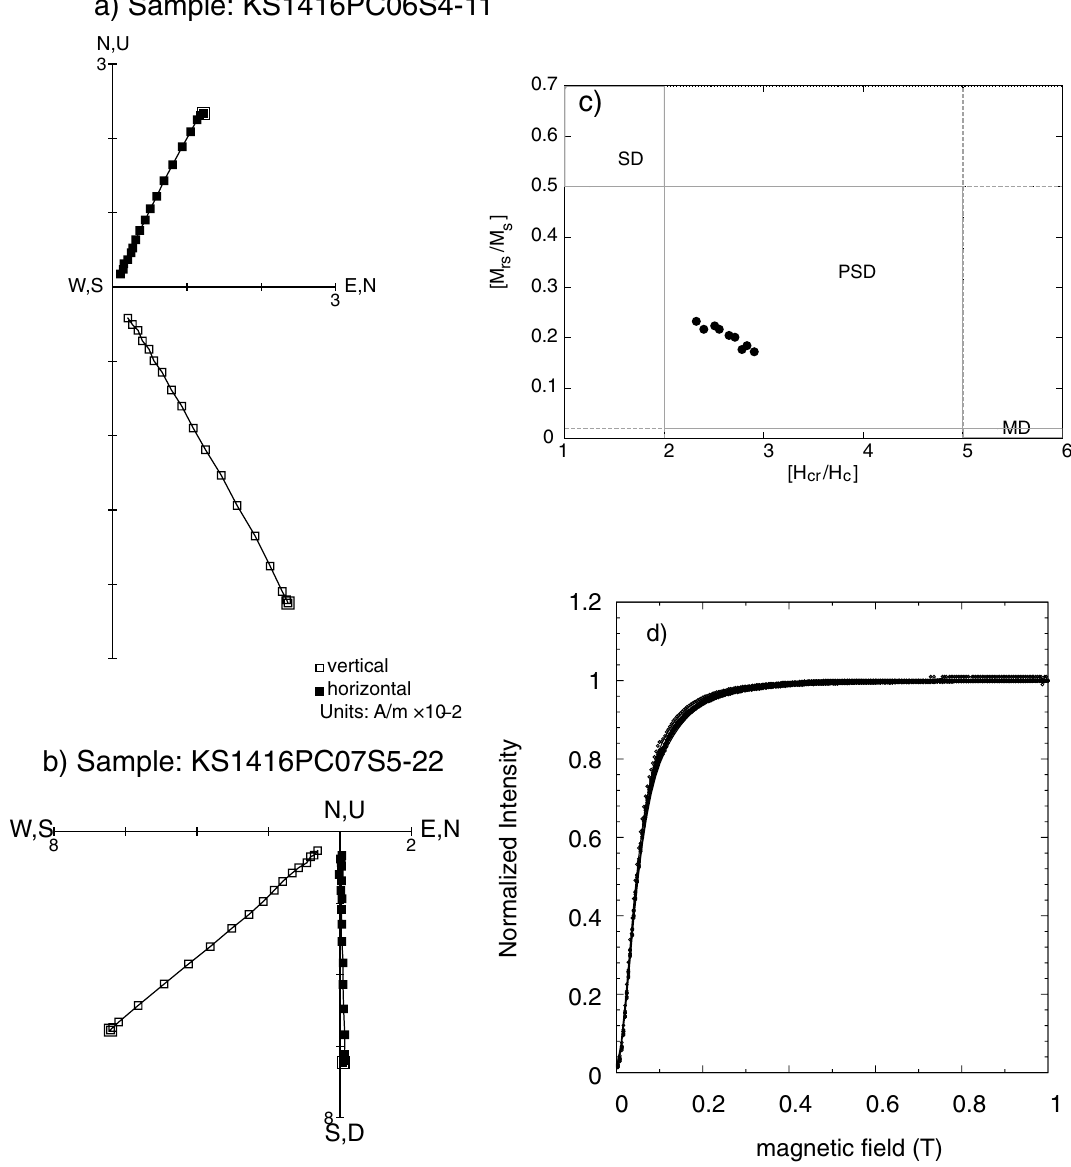
Fig. 4 Orthogonal projections of AFD experiment. a Sample KS1416PC06S4‑11 and b sample KS1416PC07S5‑22: s. c “Day plot” (Day et al. 1977) for hemipelagic samples. SD, PSD and MD, respectively, denote single domain, pseudo‑single domain and multidomain fields. d Stepwise IRM acquisition experiments on 9 samples